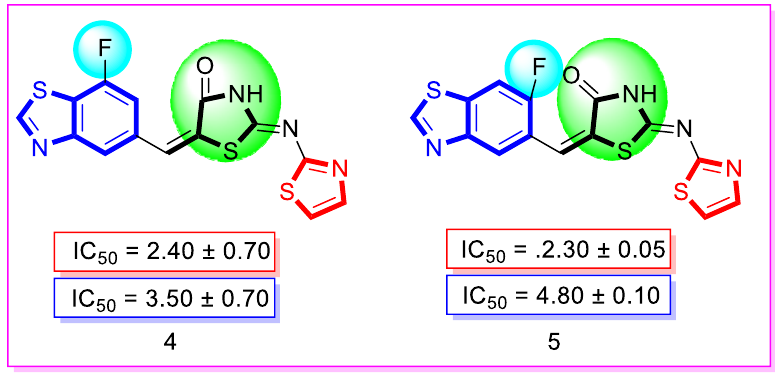
Figure 4. SAR study of analogues 4 and 5.